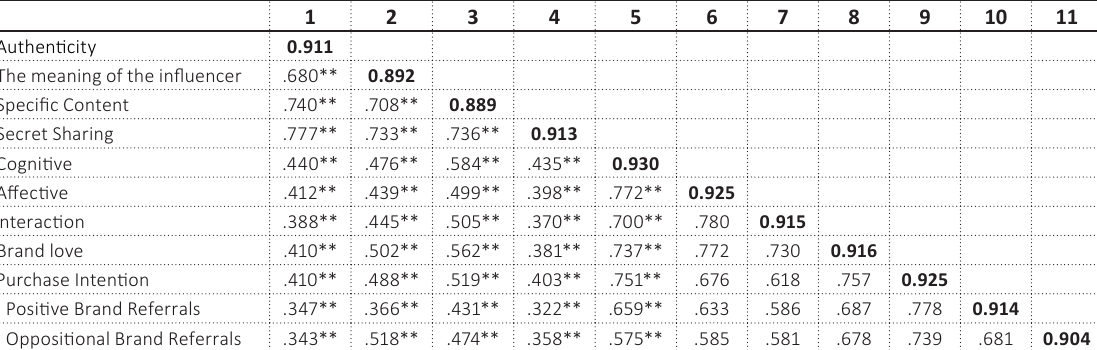
Table 2. Discriminant validity